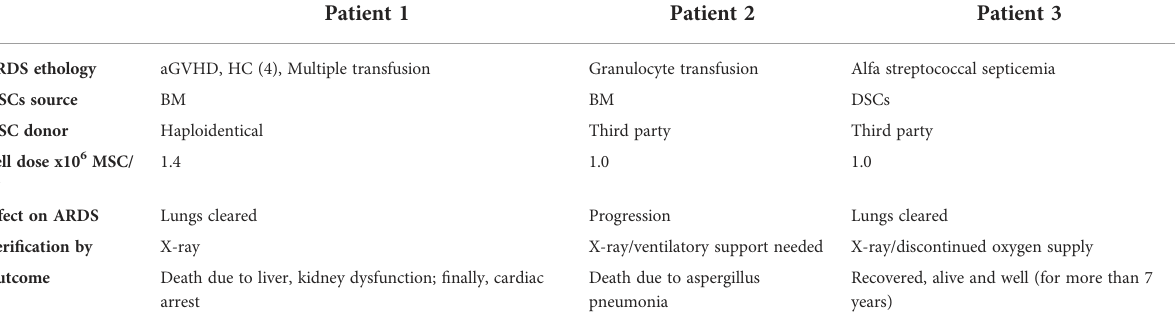
TABLE 2 Outcome of three patents, diagnosed with ARDS and treated with